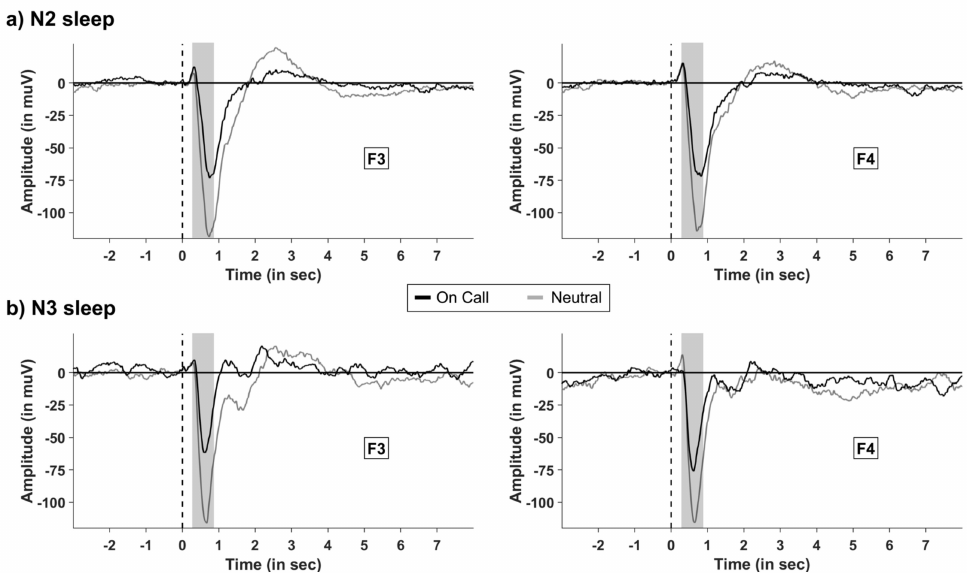
Figure 3. The effect of instruction on event-related potentials (ERP) in frontal electrodes during N2/N3 sleep. Grand-average ERP and reaction times to alarm sounds in the “sound” group in frontal electrodes F3 and F4 for N2 sleep ( a ) and N3 sleep ( b ). The instruction to react to sound stimuli consistently reduced the amplitude to sounds in a time range between 400 and 800 ms at both frontal electrodes recording sleep and both during N2 and N3 sleep. Data were baseline-corrected for a period of − 1000 to 0 ms before the sound